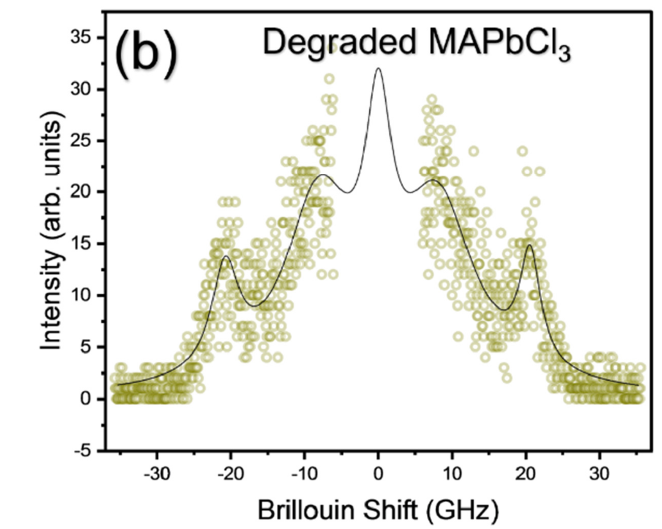
Figure 10. (Color online) Comparison of Brillouin spectra of pristine ( a ) and degraded MAPbCl 3 at high temperatures and cooled to RT ( b ). The circles and the solid line indicate the raw data and best-fitted result, respectively.